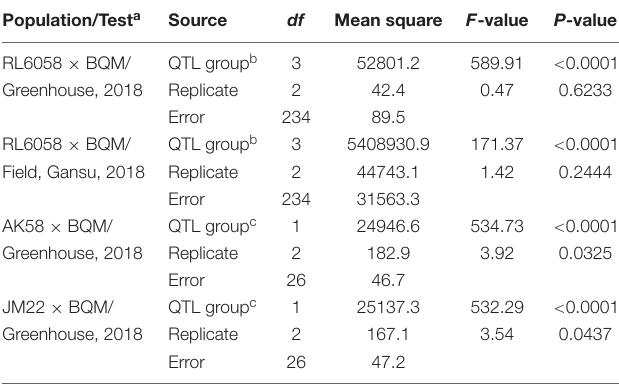
TABLE 6 | Analysis of variance of leaf rust severities for the selected F 2 : 3 family groups from RL6058 × BQM under greenhouse conditions and in the Gansu field in 2018, and the selected BC 3 F 2 : 3 family groups from AK58 × BQM and JM22 × BQM under greenhouse conditions in 2018. Population/Test